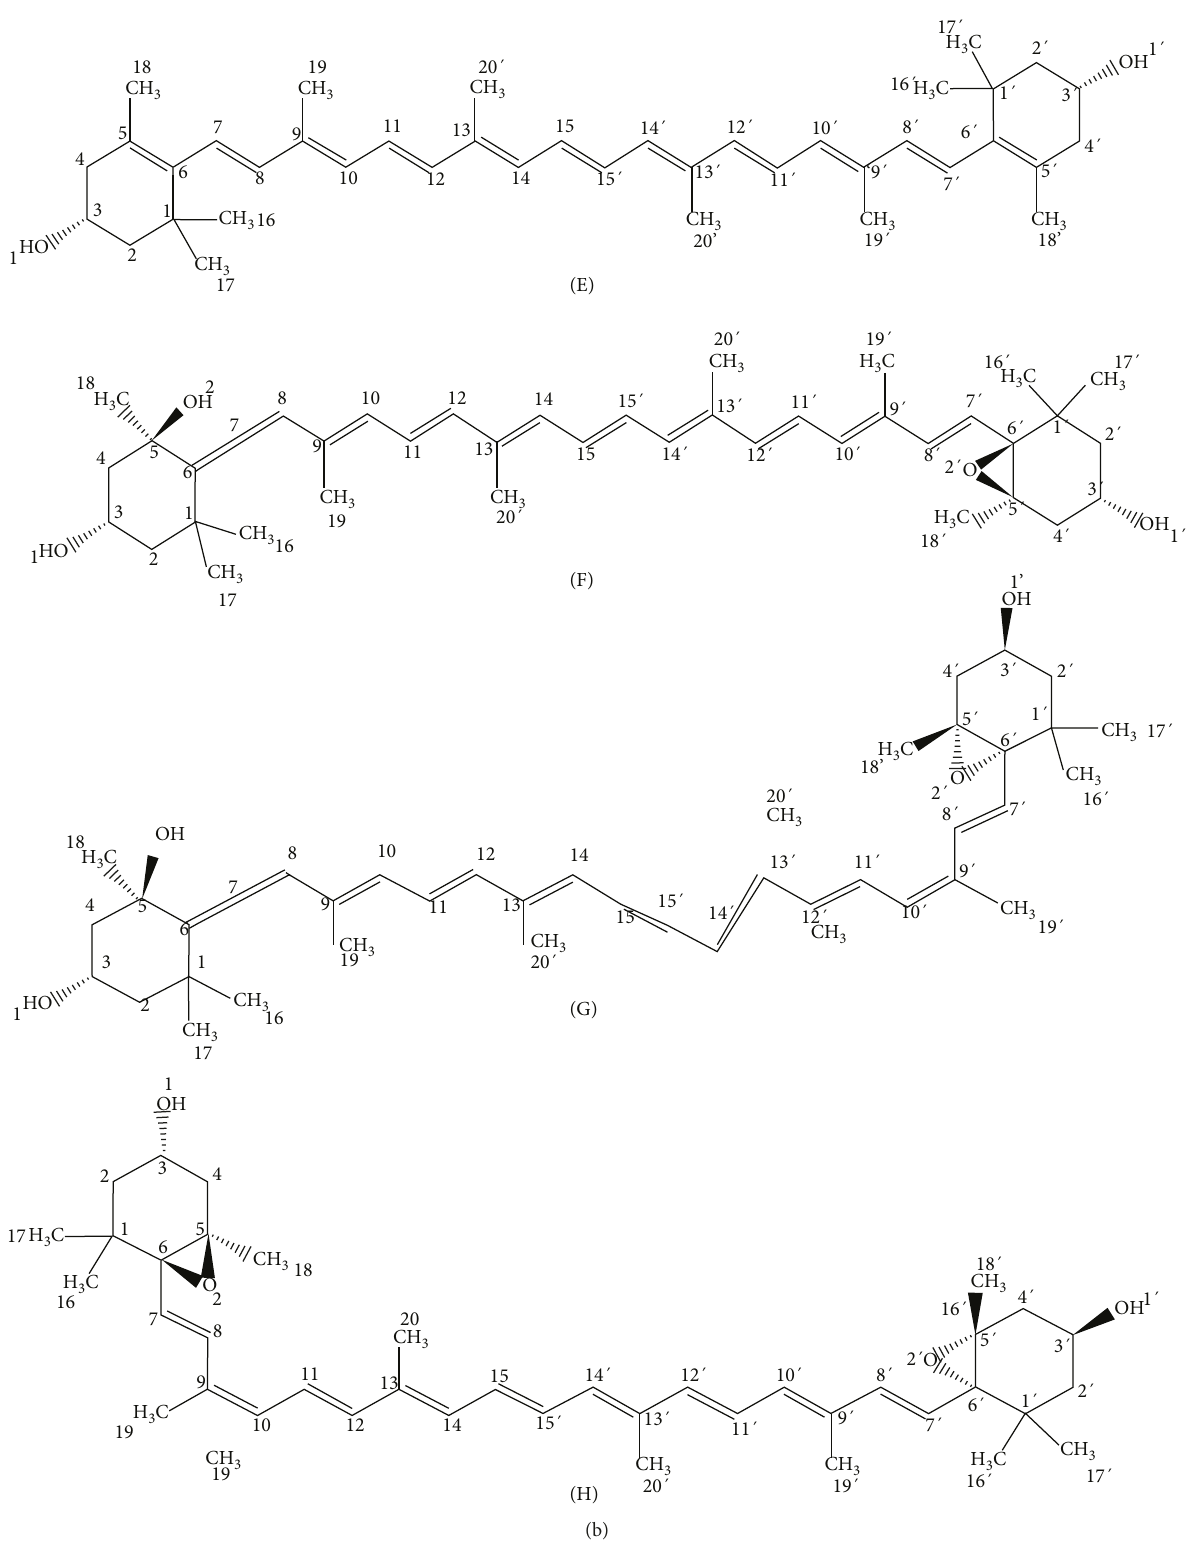
Figure 1: (a) Structures for (A) methyl chlorophyllide a , (B) methyl chlorophyllide b , (C) all- trans - β -cryptoxanthin, and (D) all- trans -lutein. (b) Structures for (E) all- trans -zeaxanthin, (F) all- trans -neoxanthin, (G) 9 ′ - cis -neoxanthin, and (H) 9- cis